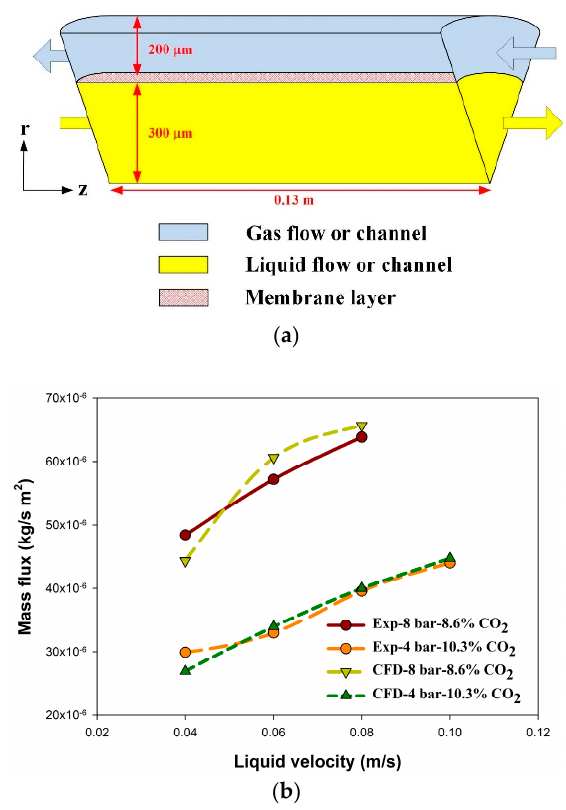
Figure 6. Model verification using experimental data from [25]: ( a ) simulation system; ( b ) comparison of simulated and experimental transmembrane CO 2 mass flux.